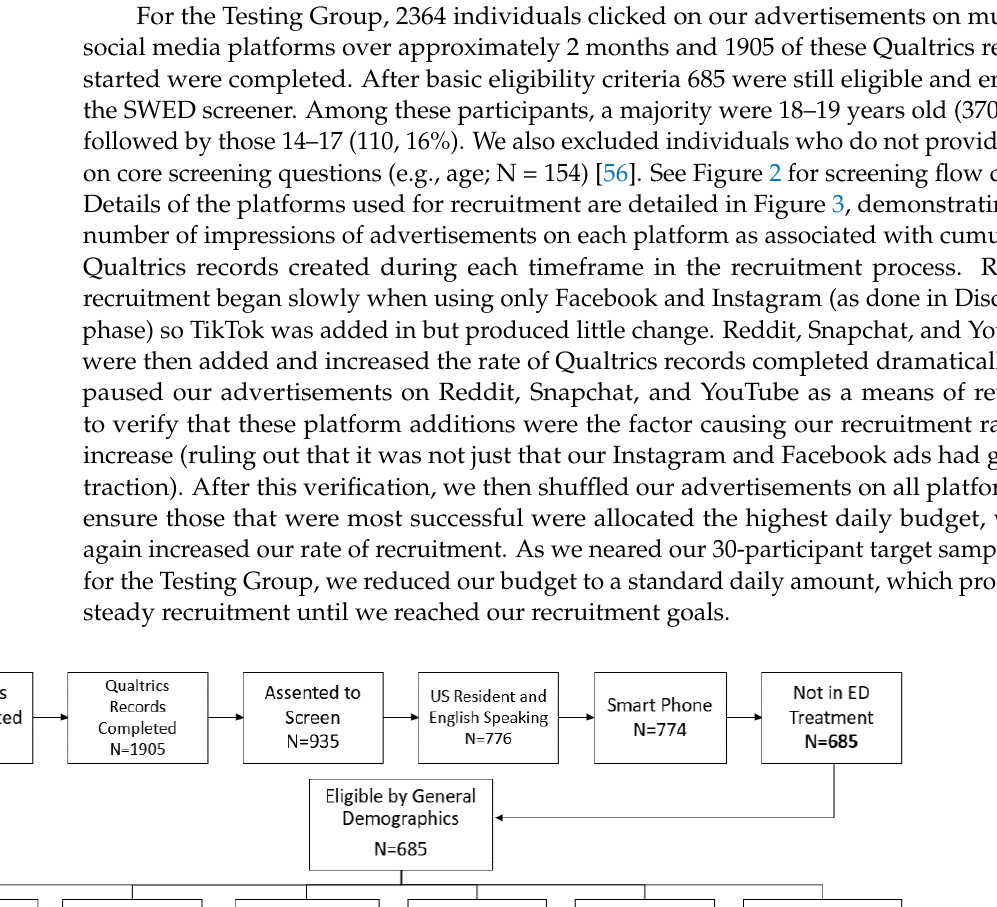
Figure 3. Cumulative Qualtrics records created compared to recruitment platforms used to recruit the Testing Group. ( A ) Facebook/Instagram (FB/IG) only, added in TikTok, ( B ) three additional platforms added, ( C ) paused additional platforms (reversal design), ( D ) all platforms with ads shuffled and more money allocated to Snapchat and Reddit, ( E ) reduced to standard daily budget.